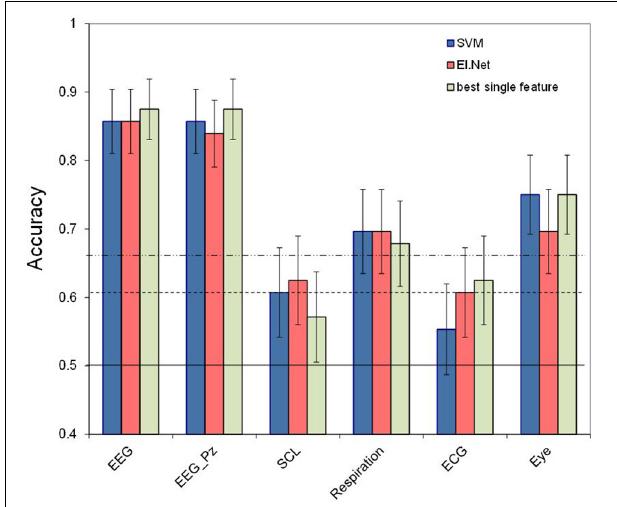
FIGURE 2 | Classification performance (2- vs. 0-back, 120s) for separate sensors. Conventions as in Figure 1 . For comparison, performance of the best performing feature for each of sensor is